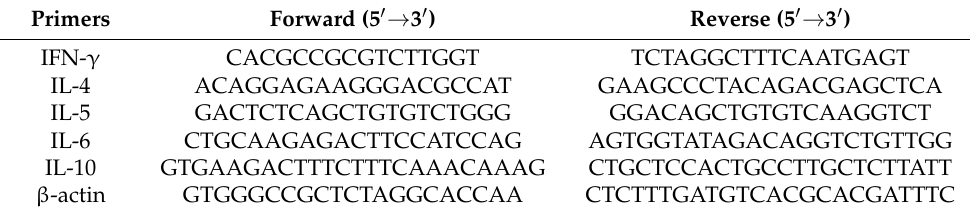
Table 1. List of the study